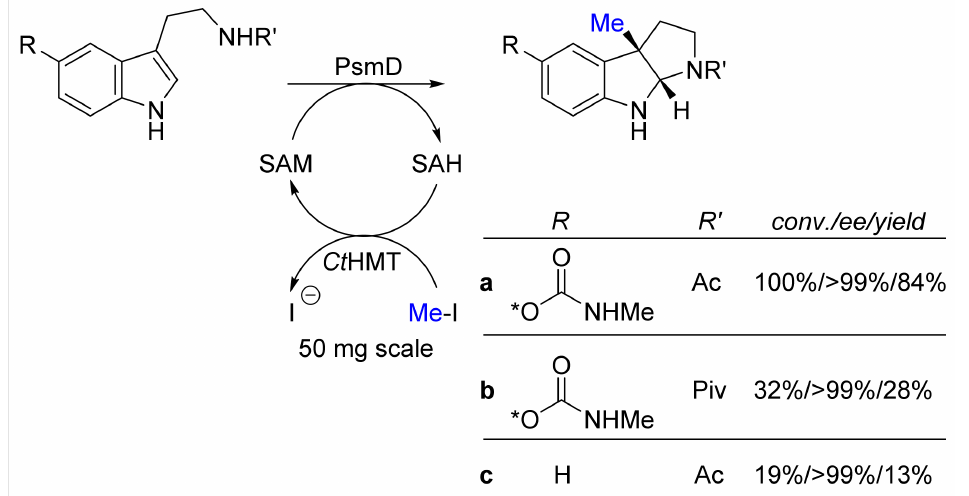
Figure 7. The methylation of the indole causes the cyclisation towards compound. S -Adenosyl methionine (SAM) is recycled from S -adenosyl homocysteine (SAH) and methyl iodide by the auxiliary enzyme Ct HMT